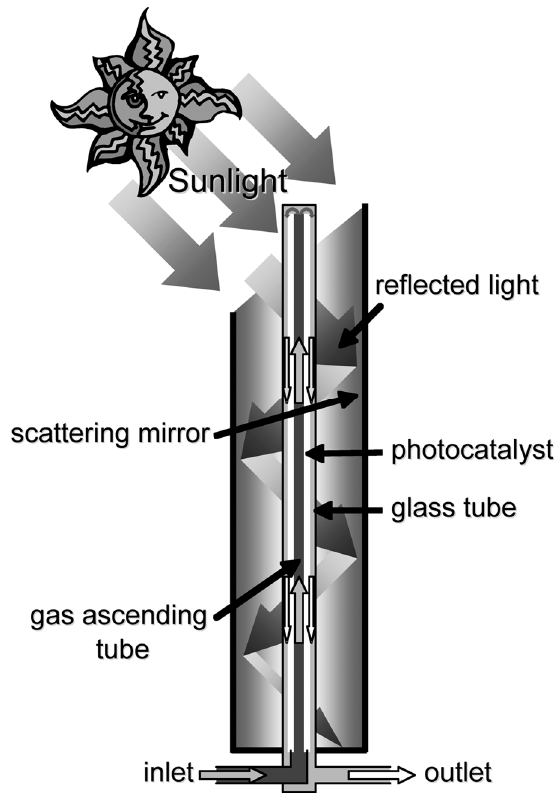
Figure 8. Schematic diagram of the solar tower